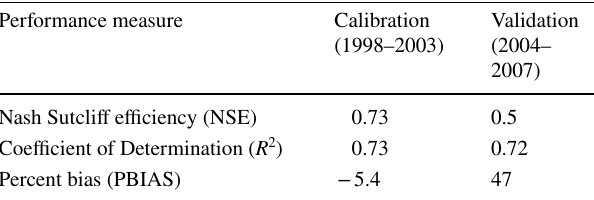
Table 6 Performance